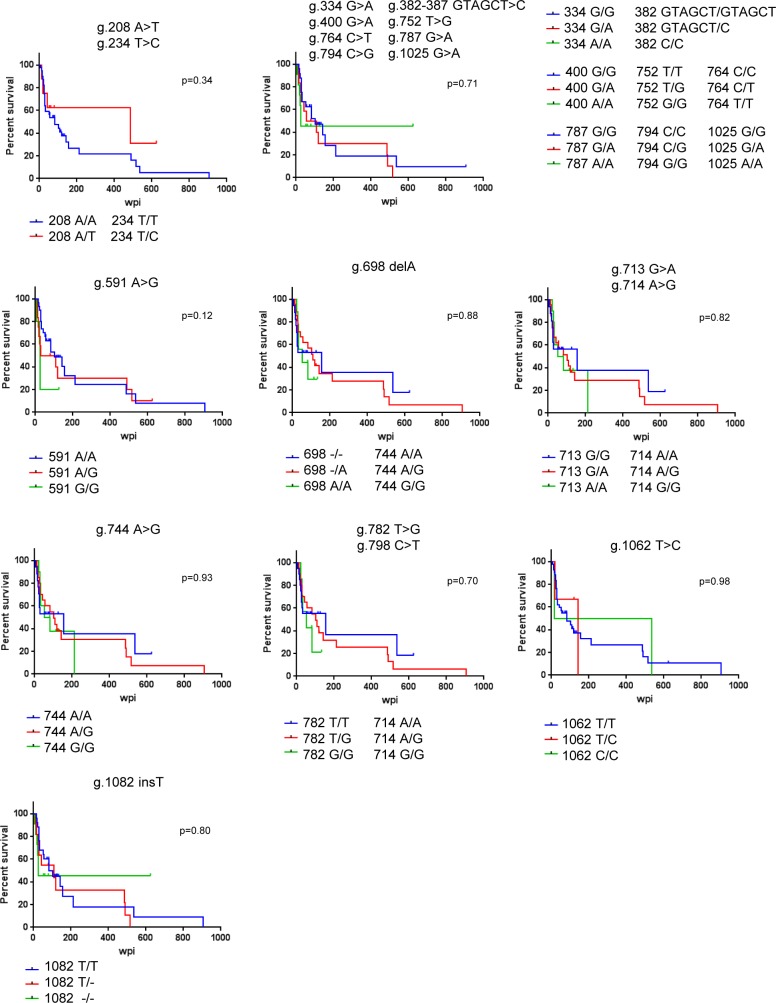
rhIFITM3(2) alleles and disease progression in SIV-infected rhesus macaques.For each polymorphism, the AIDS-free survival (percent survival) is depicted by a Kaplan-Meier plot. Censored observations are marked as black ticks. The polymorphisms are indicated above each diagram together with the p-values obtained by a log-rank test. AIDS-free survival time is shown as weeks post infection (wpi).